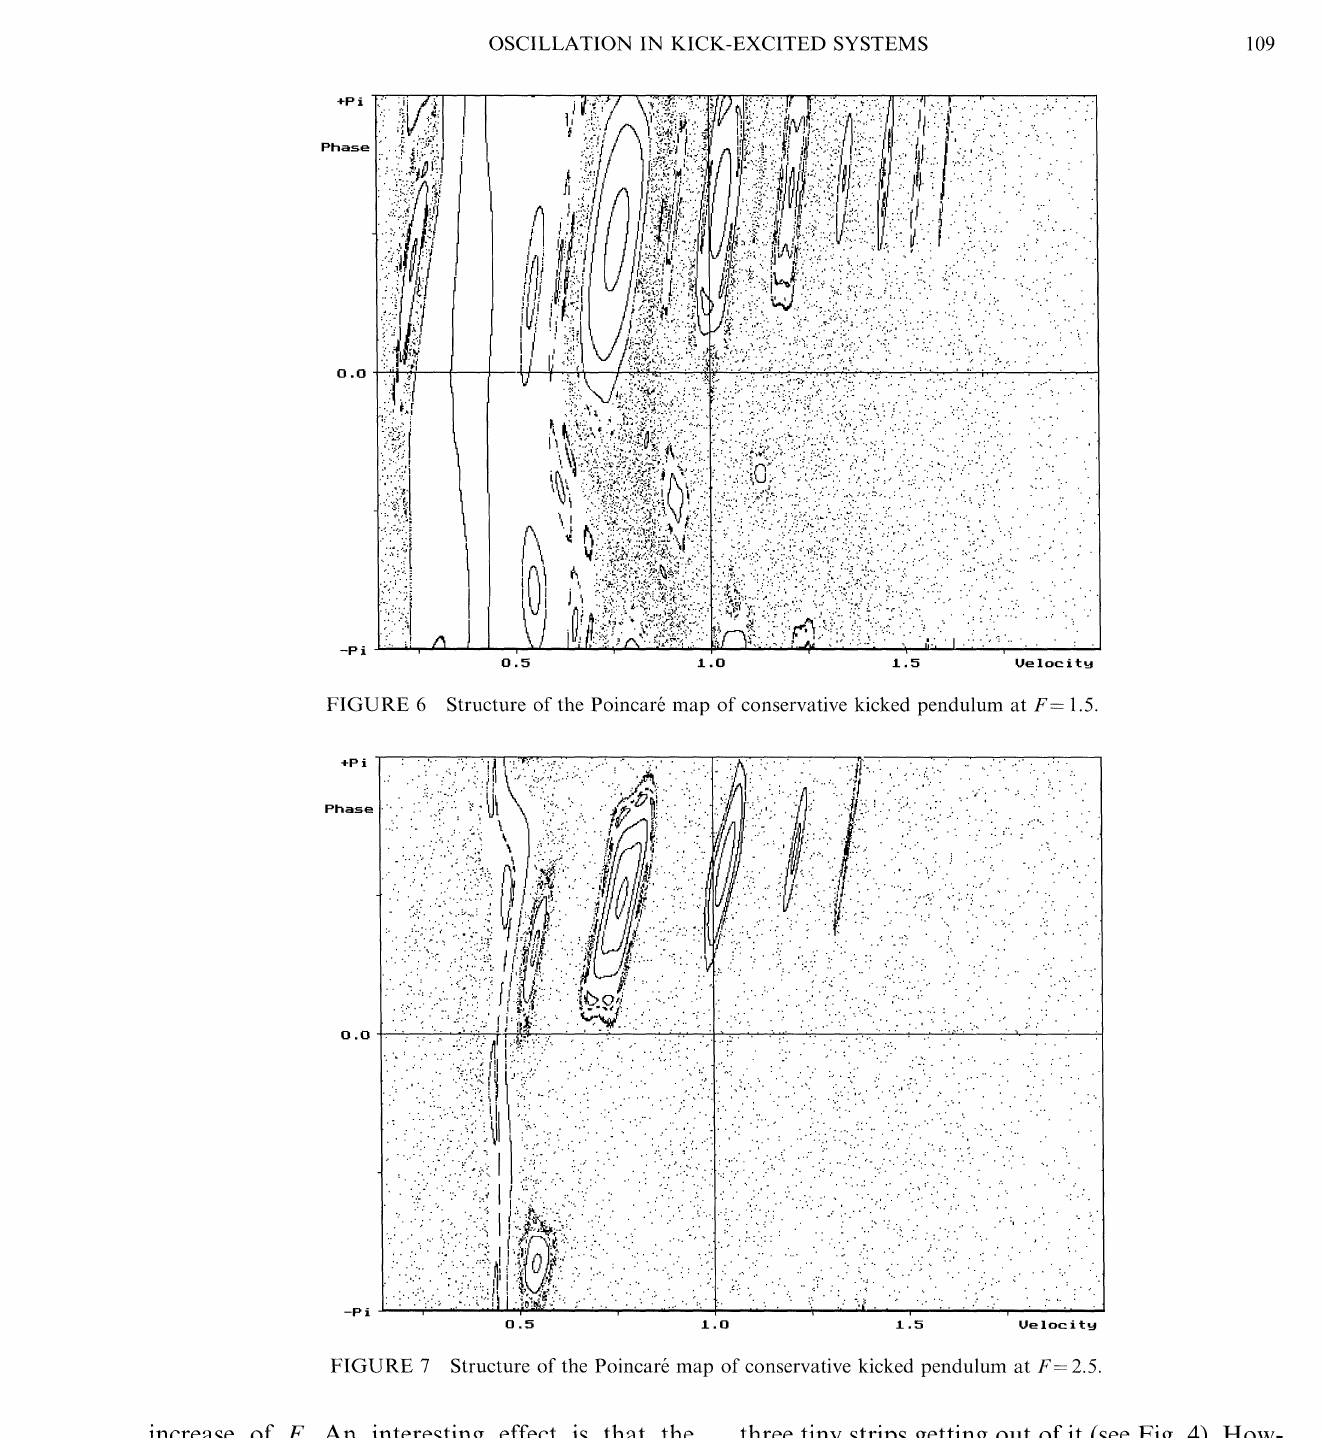
FIGURE 6 Structure of the Poincarb map of conservative kicked pendulum at F= 1.5.